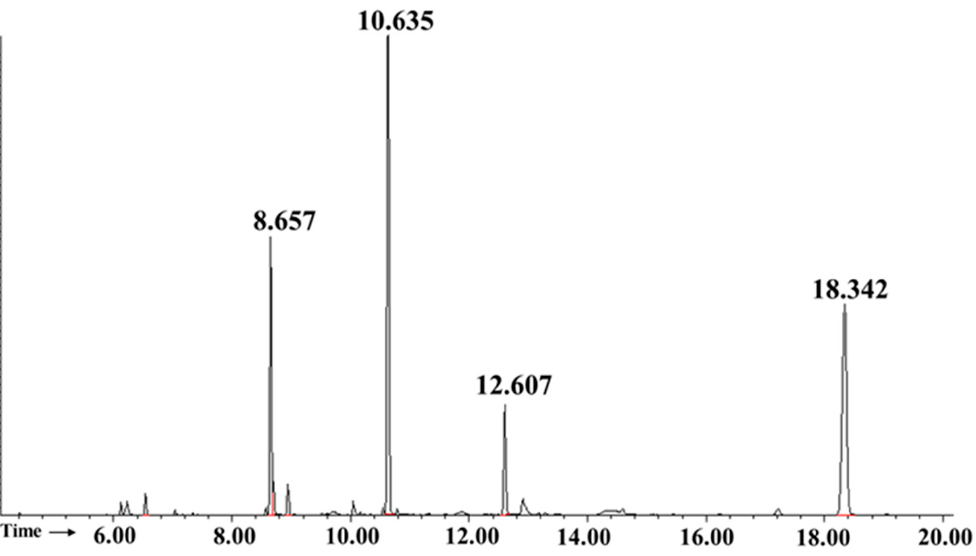
Figure 4. GC chromatogram from methylation analysis for Apilactobacillus waqarii dextran . Table 1. Linkage analysis of Apilactobacillus waqarii EPS by methylation and GC-MS .